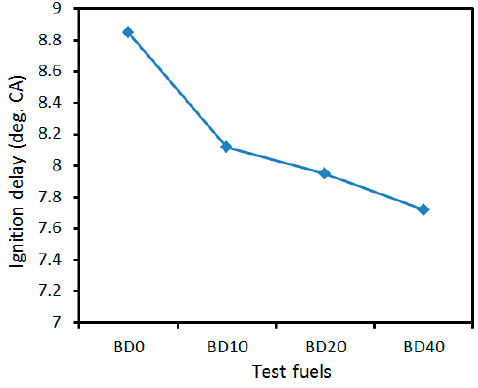
Figure 14. The ignition delay effects of diesel fuel and canola oil biodiesel. CA: crank angle (degree).